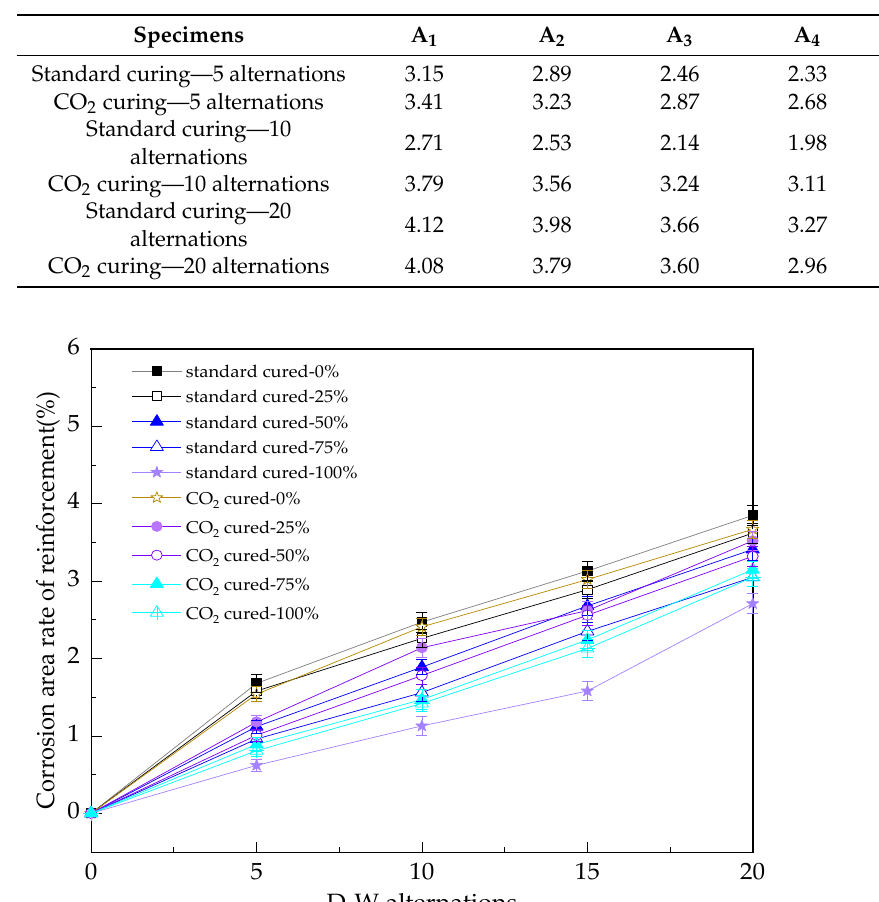
Figure 7. The Tafel curves of reinforced alkali-activated mineral admixtures after 20 D–W alternations. Table 4. The corrosion current of reinforced alkali-activated mineral admixtures(10 − 6 A/cm 2 ).